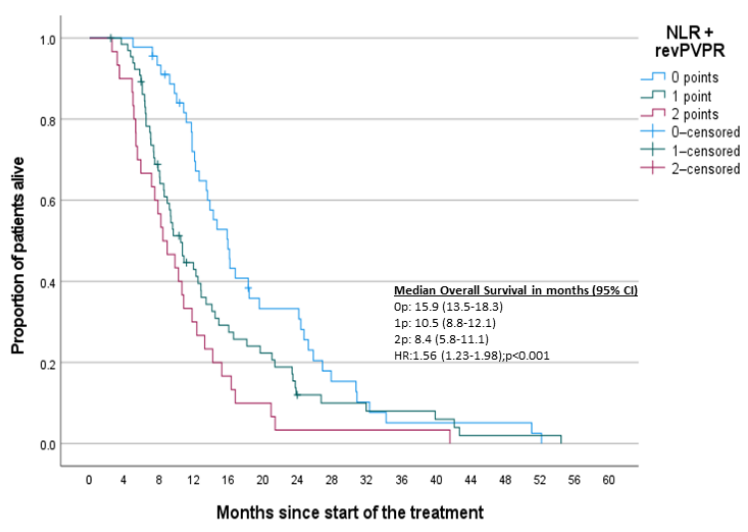
Figure 6. Kaplan–Meier curves for NLR and PVPR-OS. Note: PVPR is reversed due to opposite direction of influence.